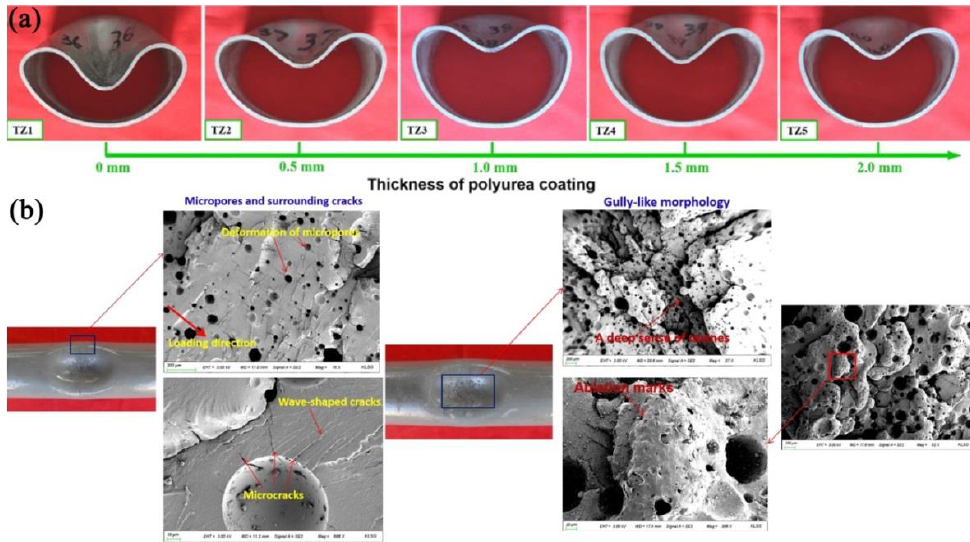
Figure 12. Damage of tubes subjected to blast loading: ( a ) Cross-section damage and ( b ) micro-morphology of polyurea layer. Reproduced with permission from ref. [16].